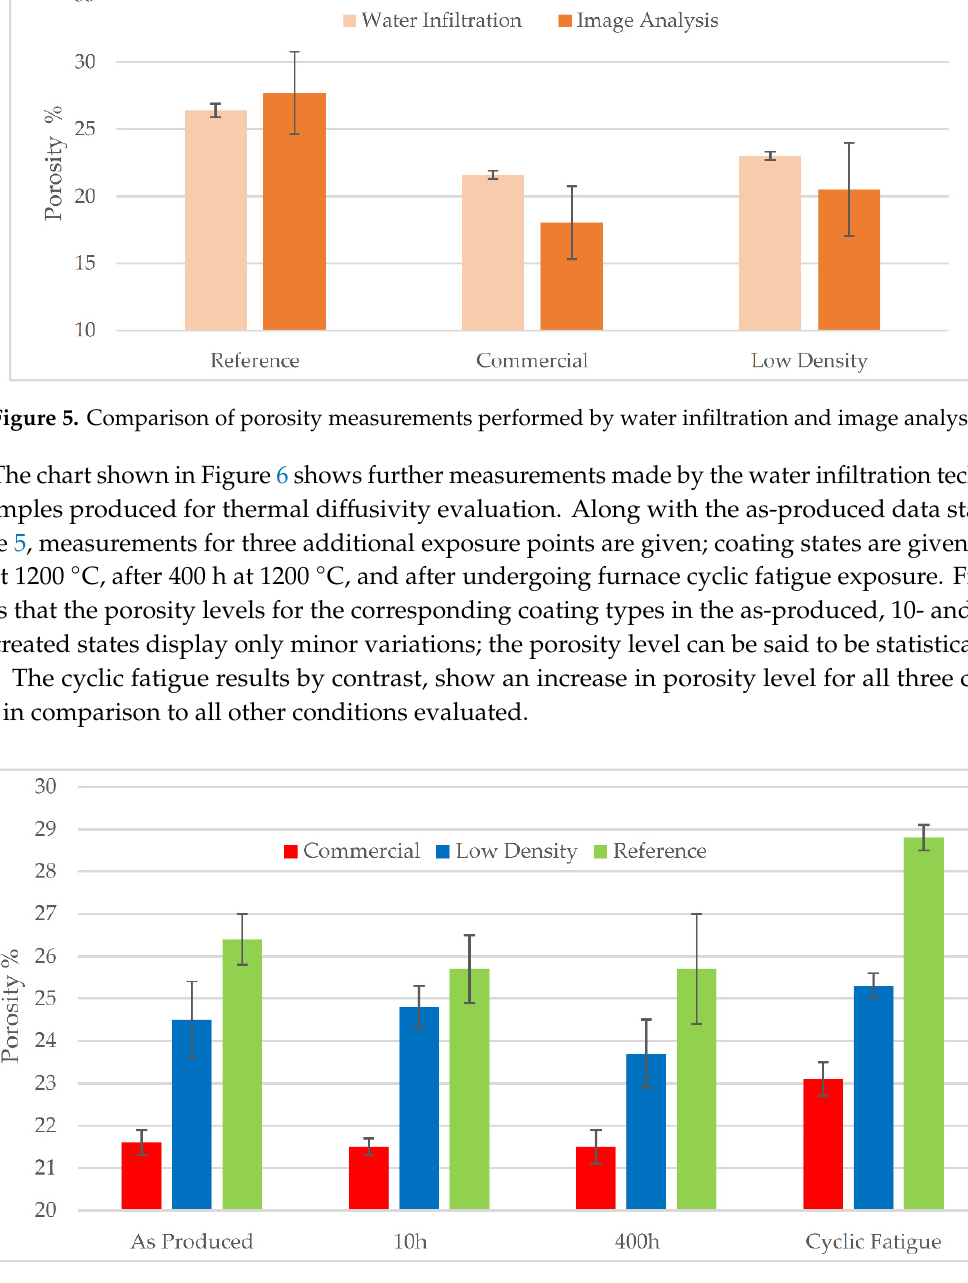
Figure 6. Total porosity for coatings in the as-produced, isothermally heat treated and thermally cycled states, evaluated by water infiltration.